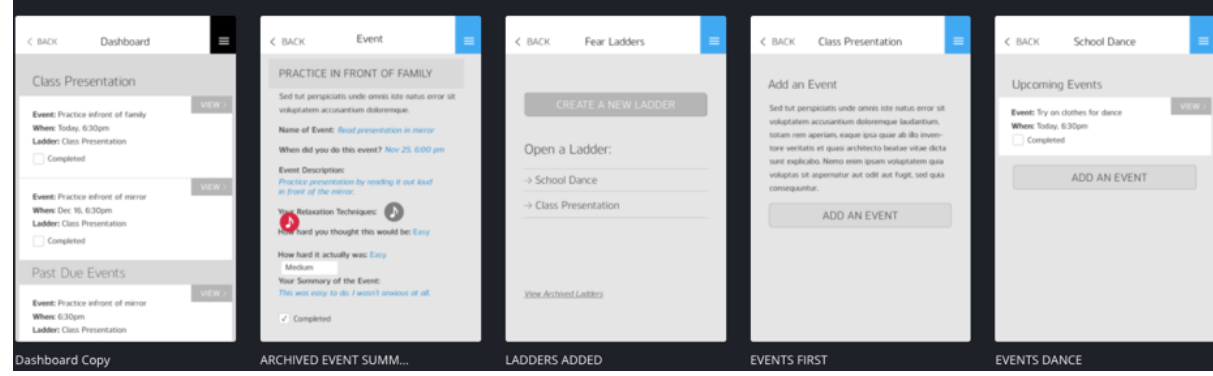
The predesign prototype was shared with NYAC members and CBT clinicians during separate 1-hour brainstorming